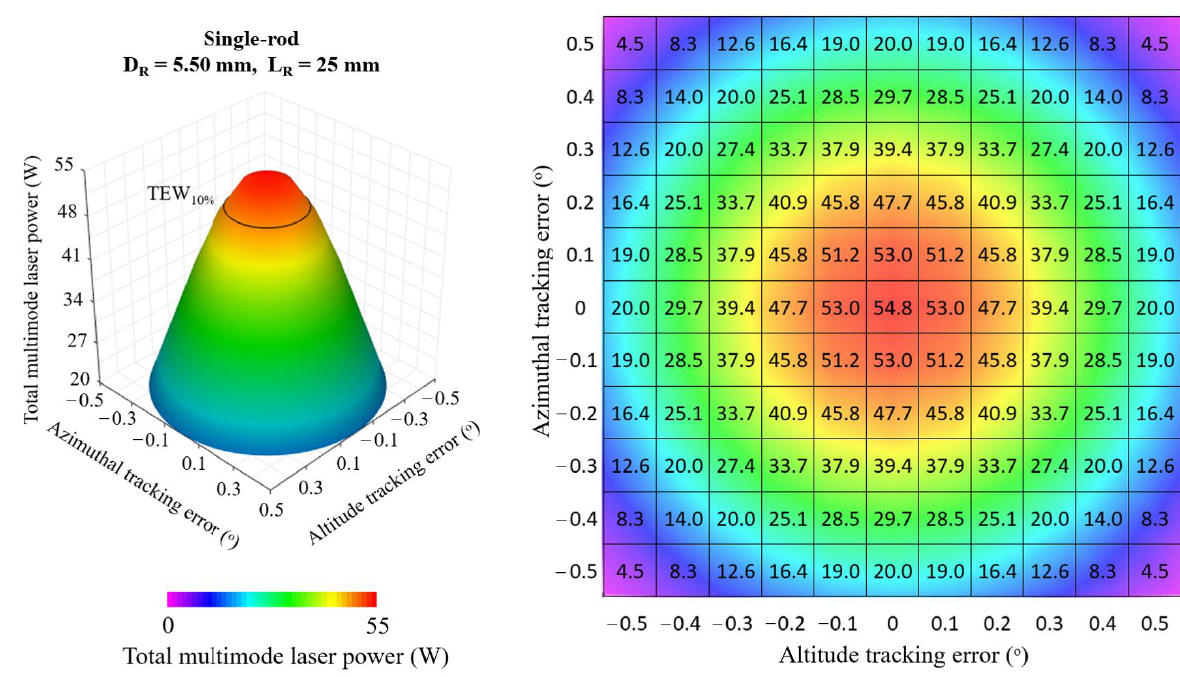
Figure 8. Total multimode solar laser power as a function of the simultaneous tracking error in altitude and azimuthal directions, ranging from the optimal alignment (0.0 ◦ ) to 0.5 ◦ , for the single-rod scheme with D R = 5.50 mm and L R = 25 mm.